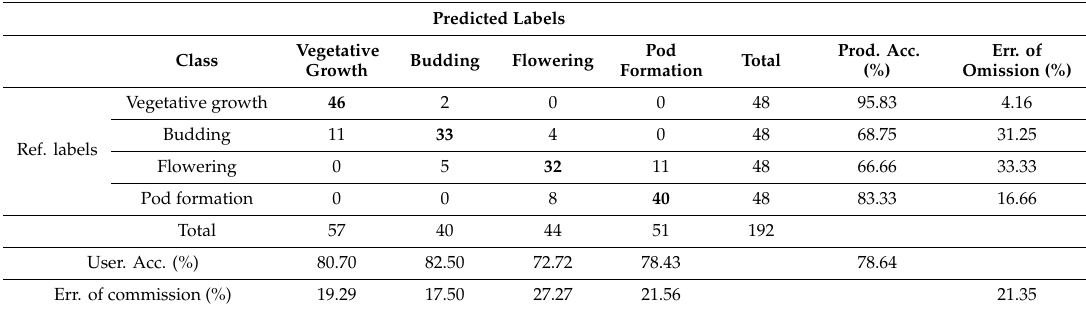
Table 8. Confusion matrix for NDSI; note the higher accuracy at the flowering stage and the lower accuracy at the pod formation